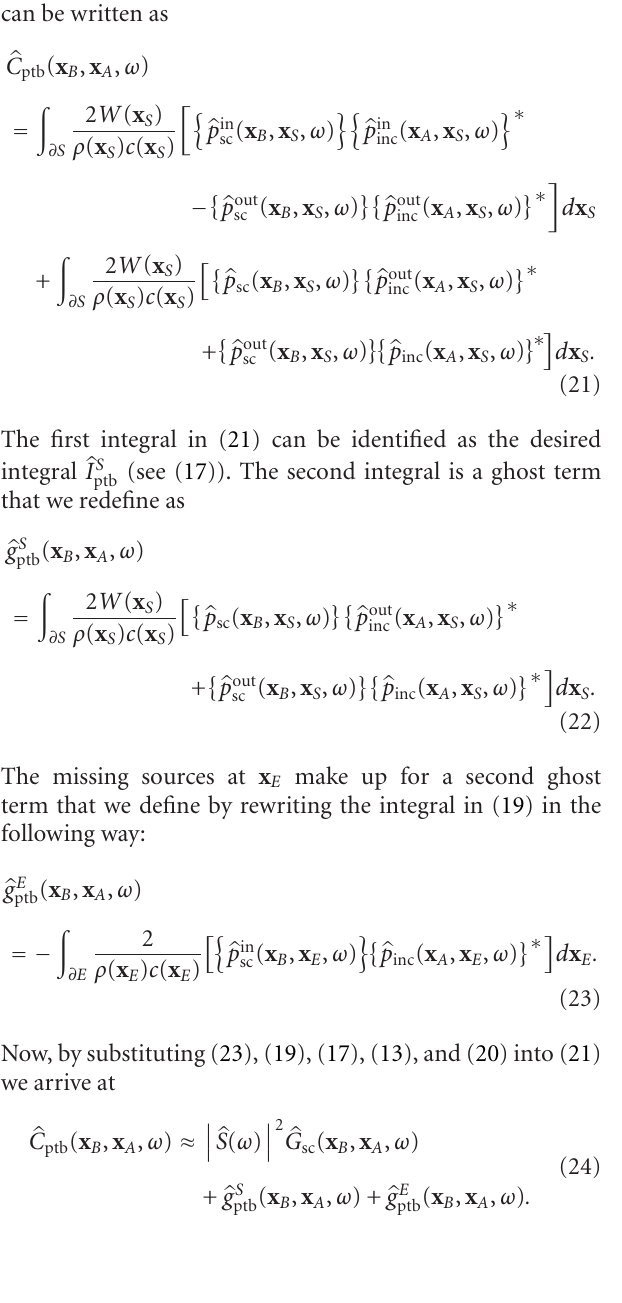
Figure 8: Configuration for controlled-source interferometry by cross-correlation of perturbed fields; volume V is enclosed by the source boundary ∂ S and an additional boundary ∂ E between overburden and target; x S denotes a source location at ∂ S and n S is the unit normal vector of this surface; x E denotes an additional source location at ∂ E and n E is the unit normal vector of this surface; heterogeneities between sources and receivers are referred to as “overburden,” whereas heterogeneities below the receivers are referred to as